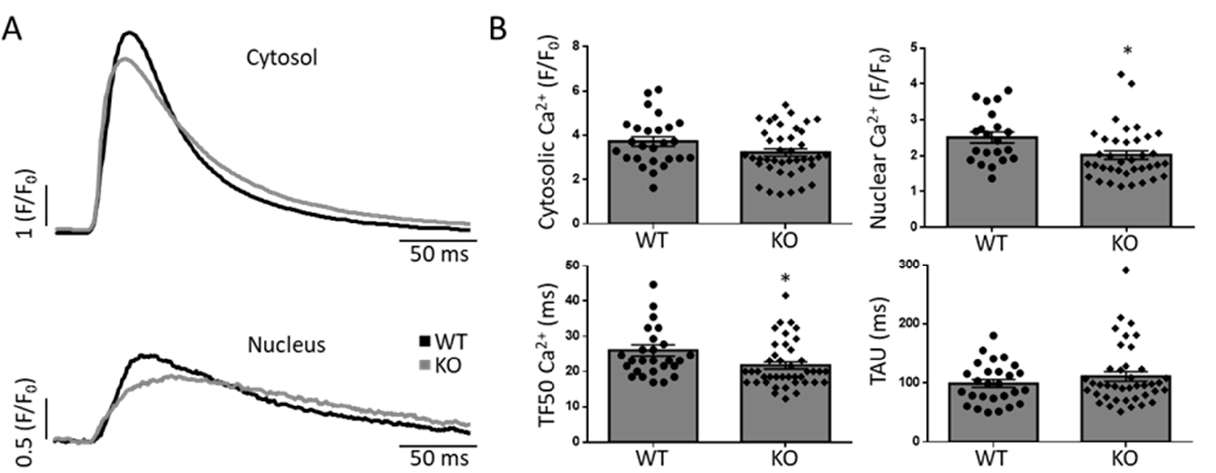
Figure 3. Properties of Ca 2+ signaling during excitation–contraction coupling in a murine model. Example of cytosolic and nuclear Ca 2+ transients during field-stimulation ( A ) and quantification ( B ) of maximal cytosolic and nuclear Ca 2+ release, time to 50% of maximal cytosolic Ca 2+ release (TF50) and the time constant of Ca 2+ decay/removal (TAU). * p < 0.05 vs. WT. Each data point represents an independent cell preparation and experiment (Cytosolic: WT n = 26, KO n = 41; nuclear: WT n = 21, KO n = 37; TF50: WT n = 27, KO n = 41; TAU: WT n = 27, KO n = 40). The total number of animals per group was n = 5 (see Supplementary Figure S1 for per-animal analyses).